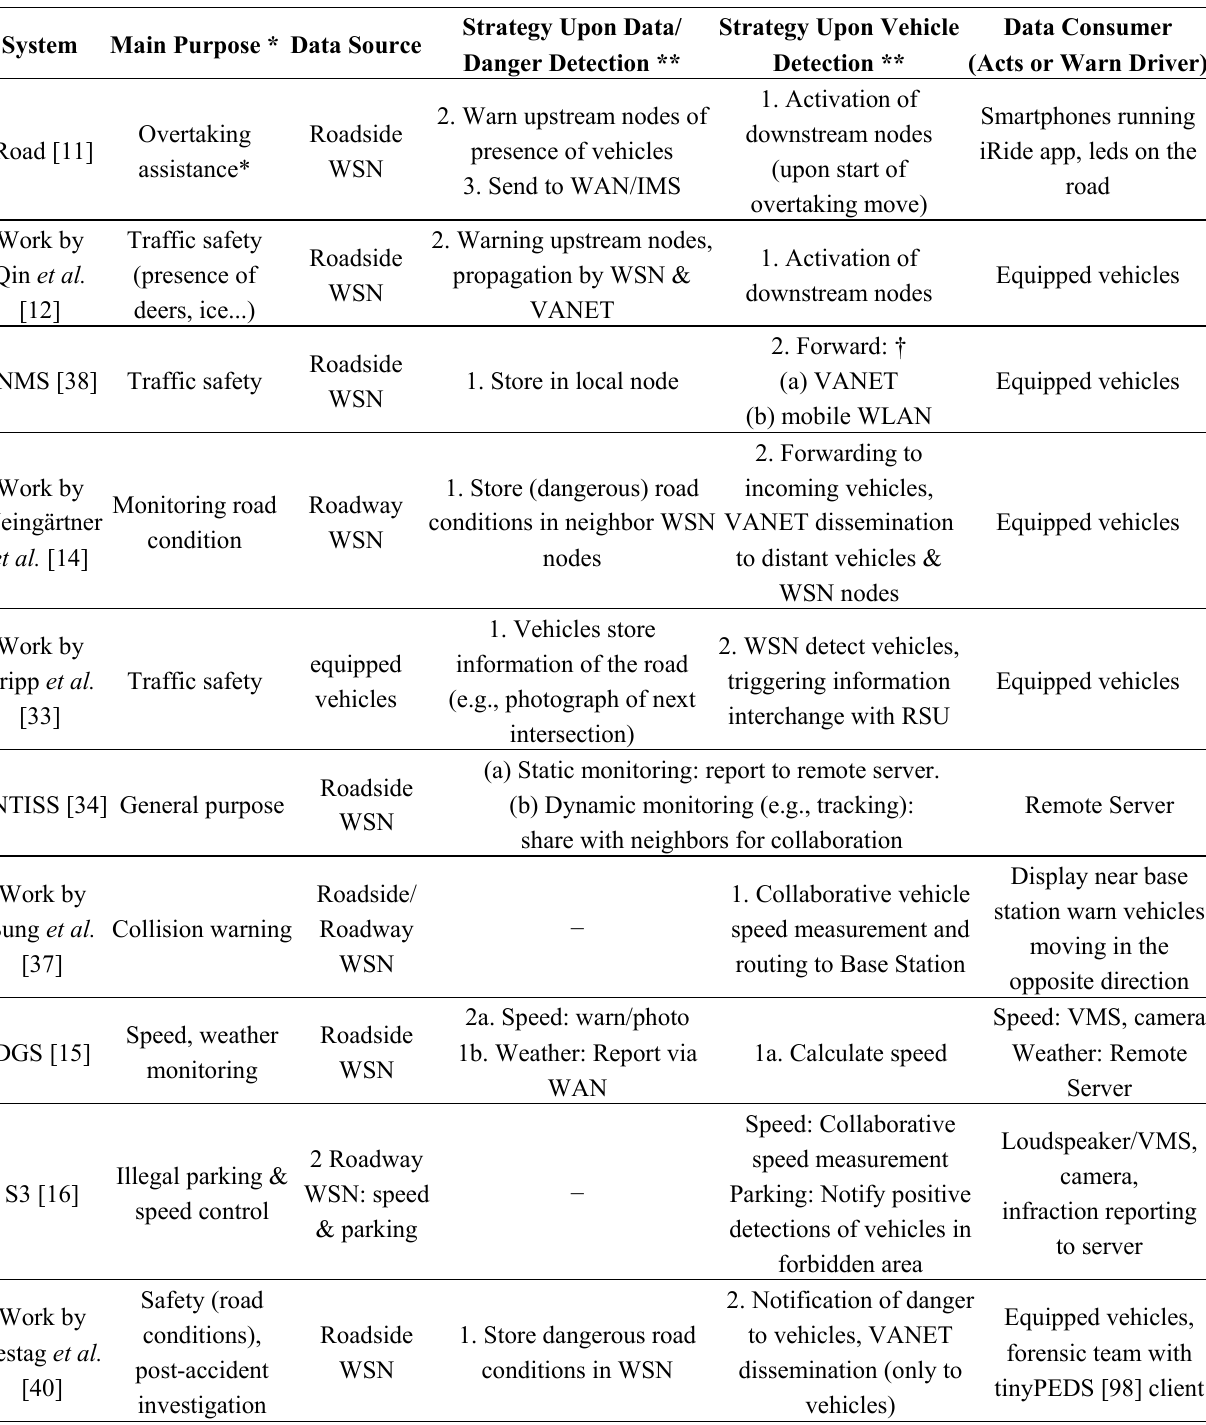
Table 1. Functional description of selected WSN-based ITS traffic safety and law enforcement